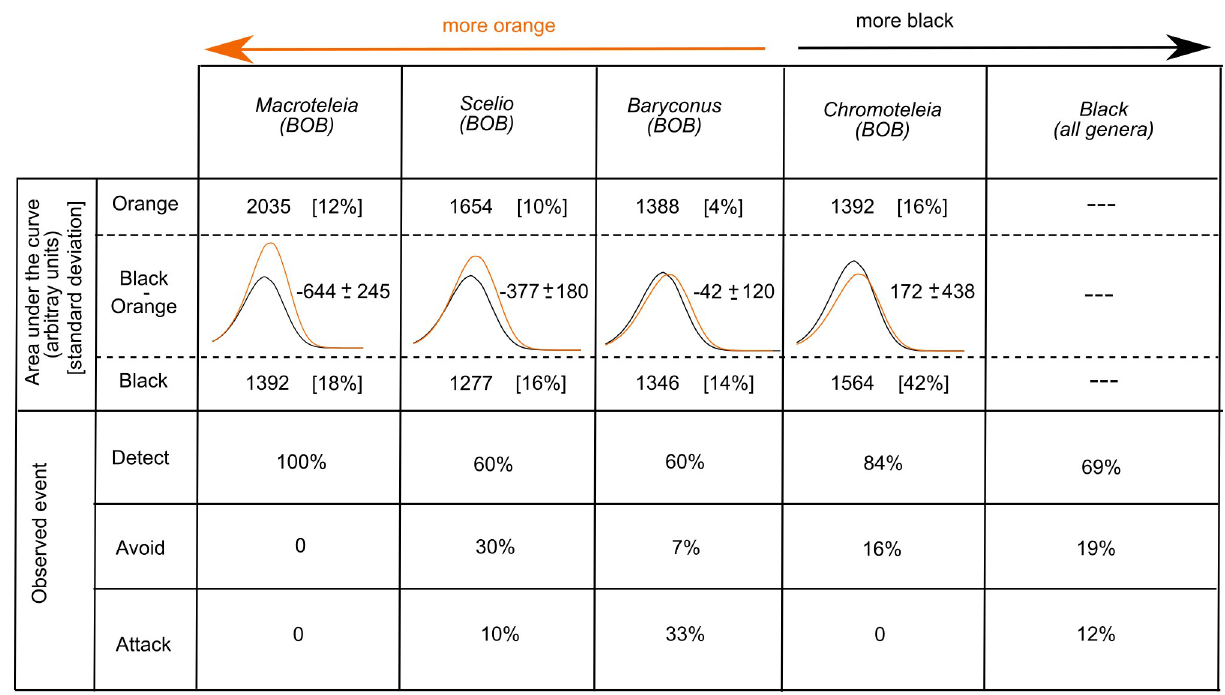
Fig 6. Relationship between the green components of the BOB colors of each scelionid genus and the percentage of behavioral responses by L . jemineus . Summary of information about the relationship between the green components of the BOB colors of each scelionid genus and the percentage of behavioral responses by L . jemineus observed and grouped in the categories “detect”, “avoid” and “attack”. The mean BOB color pattern areas under the curve, in arbitrary units, were calculated and compared for the green component of the black and orange colors, respectively (see also Fig 5). Values within square brackets represent the standard deviation of the areas.